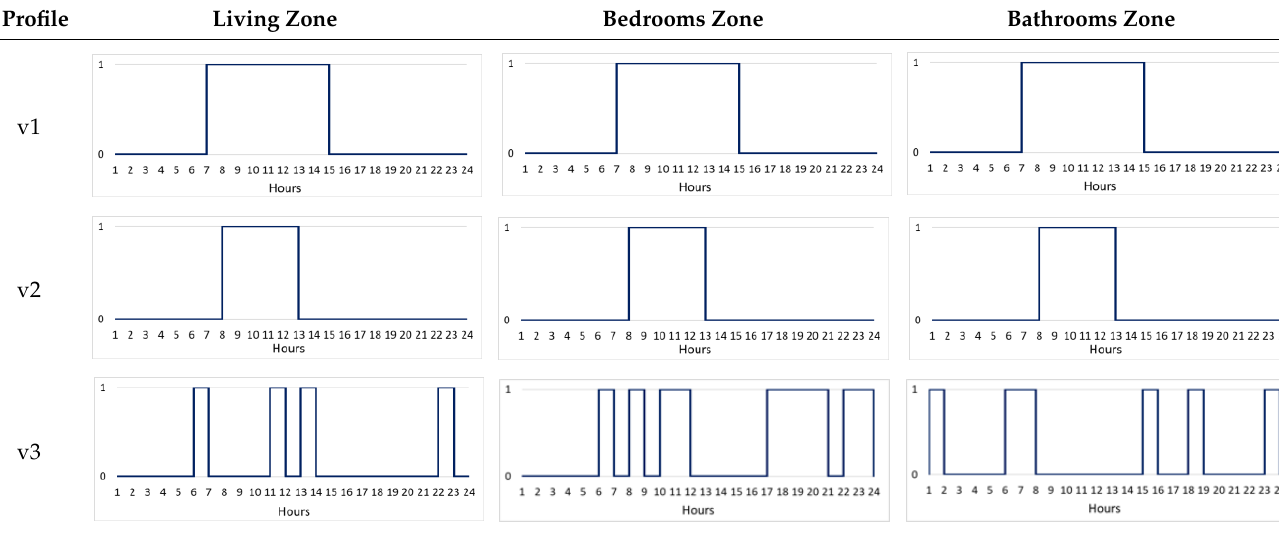
Table 4. Daily cooling schedules (On = 1, Off = 0). Adapted from [33].